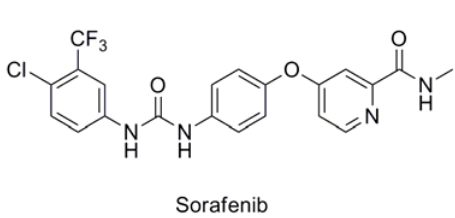
Figure 3. Structure of